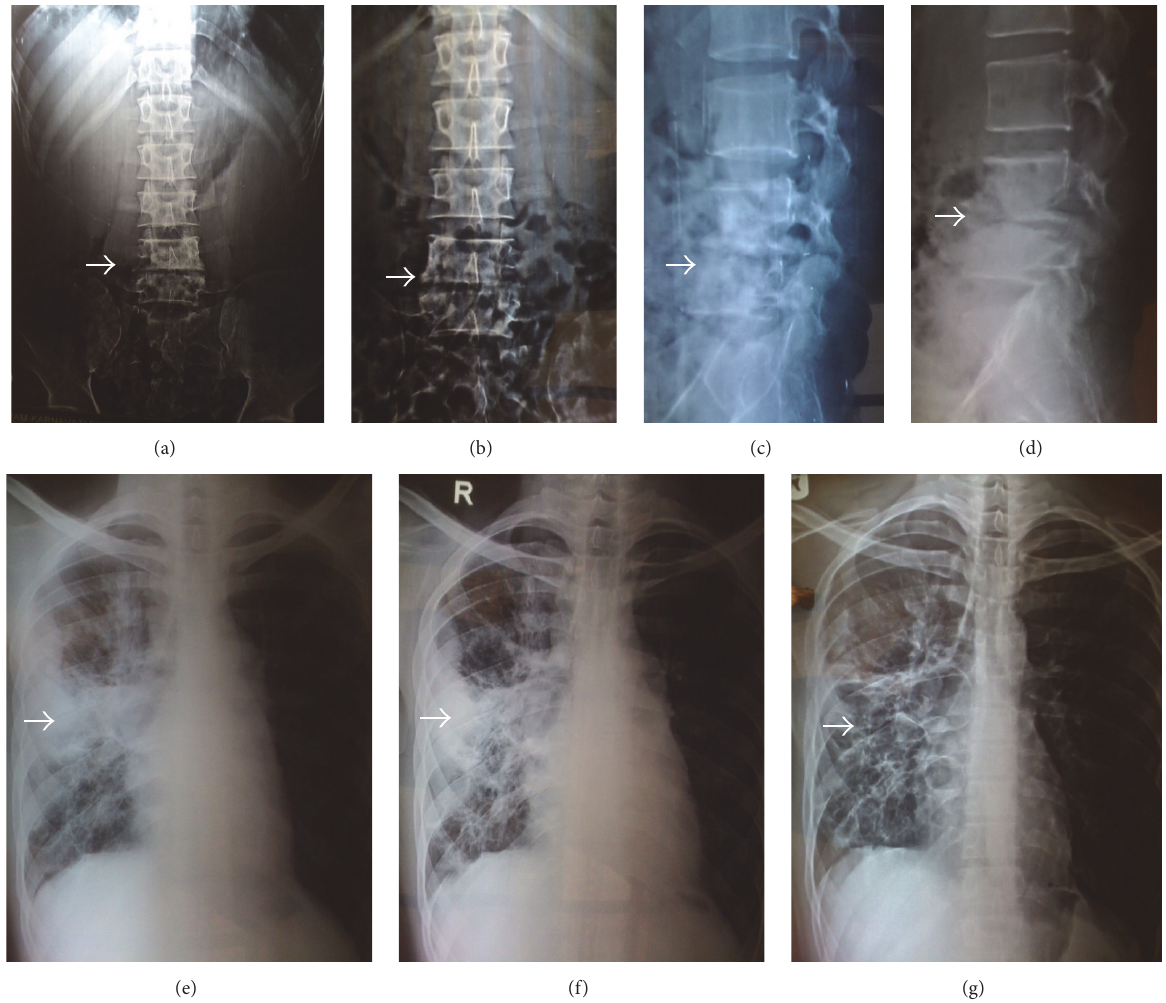
Figure 4: Radiographic evidence of improvement in spine and chest after antifungal treatment. (a) and (b) represent anteroposterior X-rays of lumbar spine, before and after treatment, respectively. (c) and (d) represent lateral X-rays of lumbar spine, before and after treatment, respectively. (e), (f), and (g) represent the sequential improvement in chest radiographs after the initiation of antifungal